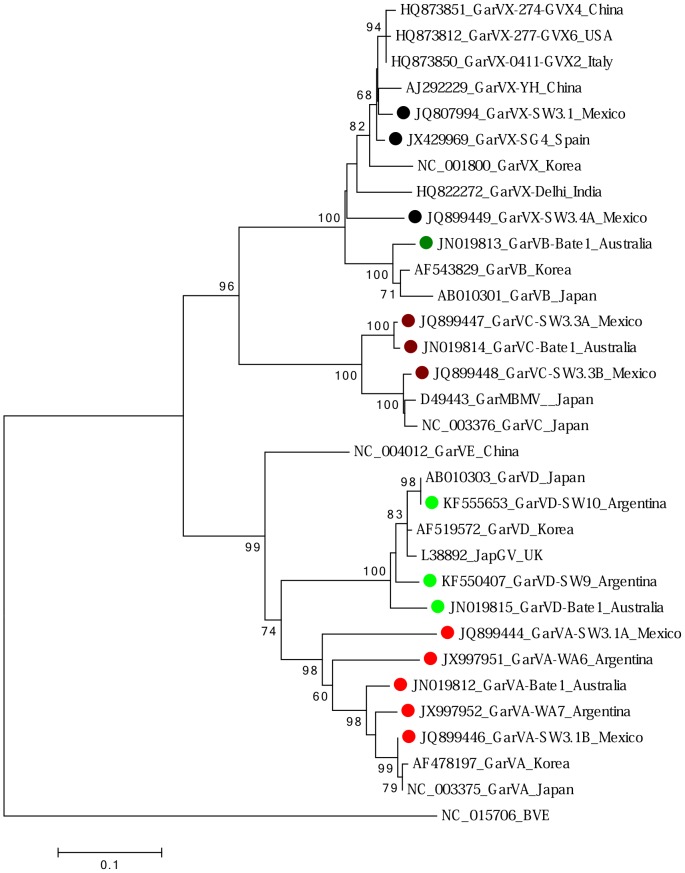
Maximum likelihood phylogenetic tree of amino acid sequences of coat proteins of isolates of allexiviruses.Virus sequences analysed were garlic virus A (GarVA) (red dots), garlic virus B (GarVB) (dark green dot), garlic virus C (GarVC) (brown dots), garlic virus D (GarVD) (light green dots), garlic virus E (GarVE) and garlic virus X (GarVX) (black dots). The CP of blackberry virus E (BVE) (Family Alphaflexiviridae) was used as the outgroup. Shown for each isolate is GenBank accession code, isolate name and country of origin. Isolates described in this study are indicated by a dot.